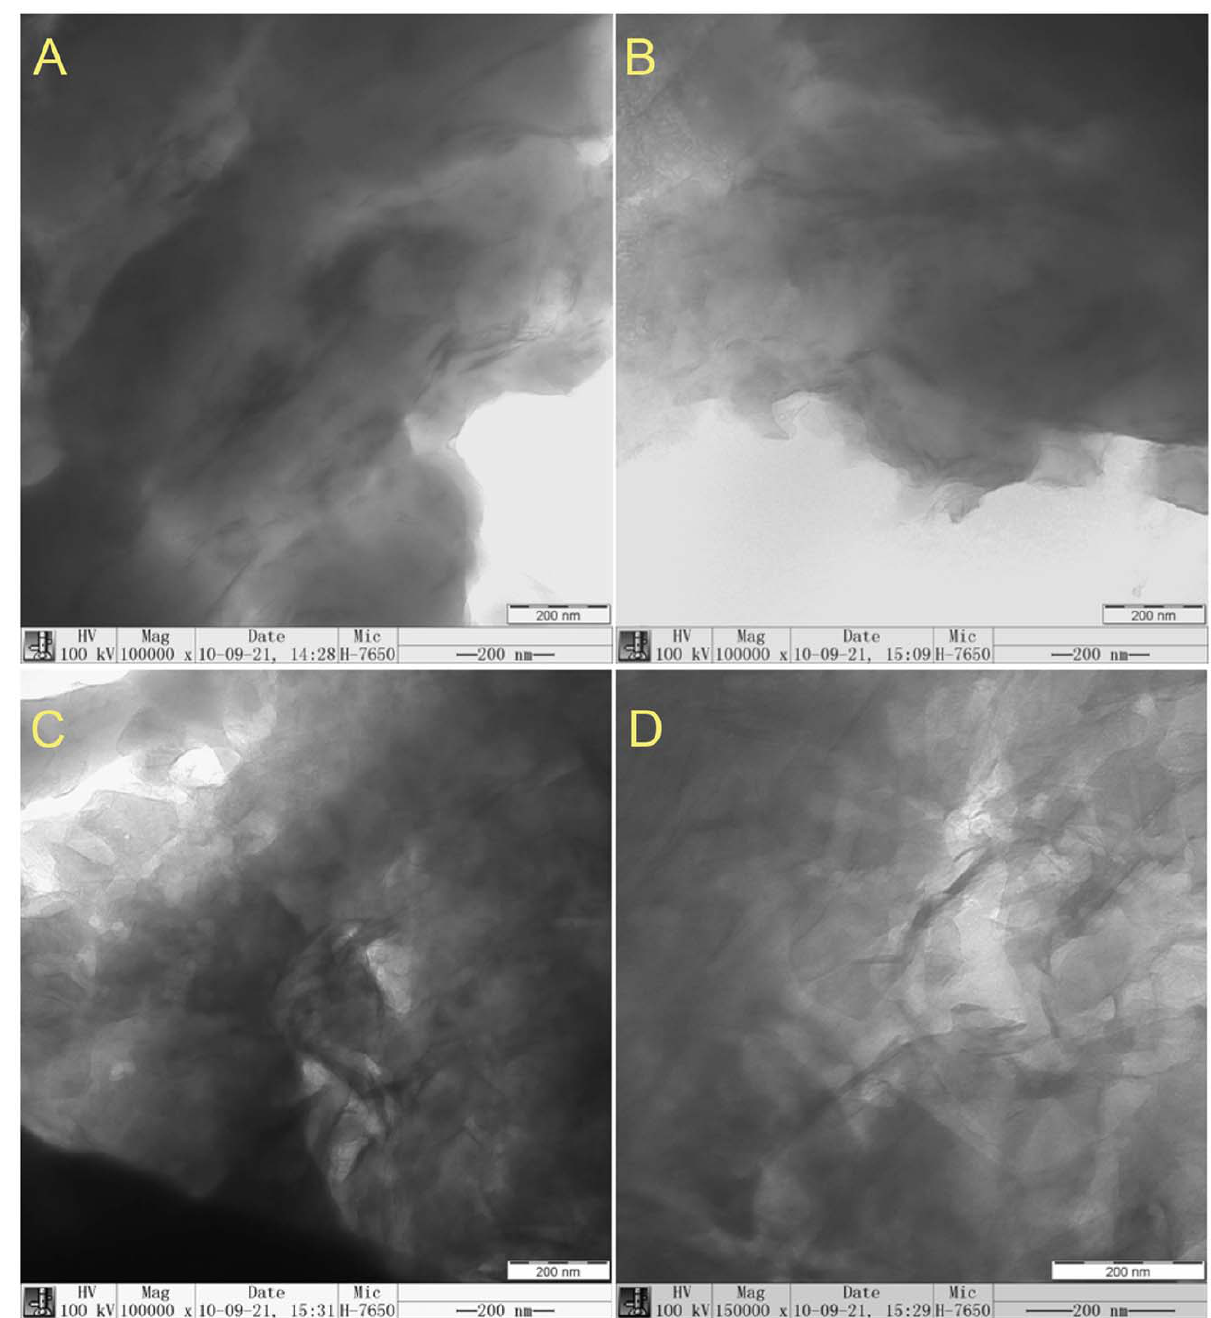
Figure 7. TEM images for LDHs/EVA composites with a loading of 20 wt% LDHs. A: S-Ni 0.1 MgAl/EVA, B: S-Ni 0.1 MgAl-Nd/EVA, C: S-Ni 0.1 MgAl- Ce/EVA and D: S-Ni 0.1